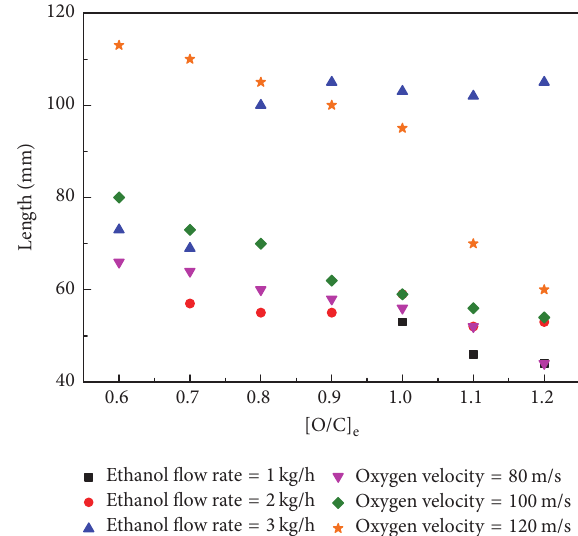
Figure 9: Comparison of flame luminous lengths at different